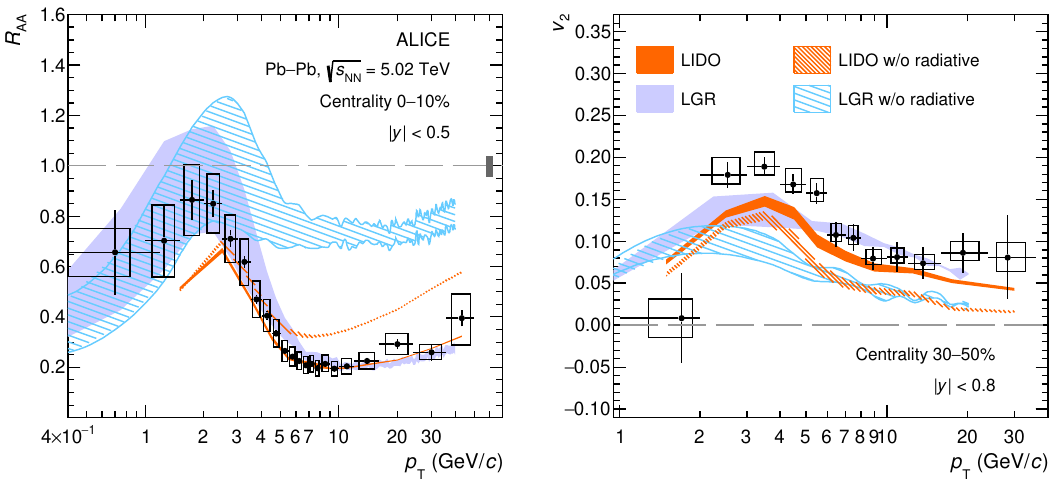
Figure 12 . Prompt D-meson R AA in the 0–10% centrality class (left panel) and v 2 in the 30–50% centrality class (right panel) compared with the LIDO [124] and LGR [121] predictions obtained with and without including radiative processes in the charm-quark interactions with the